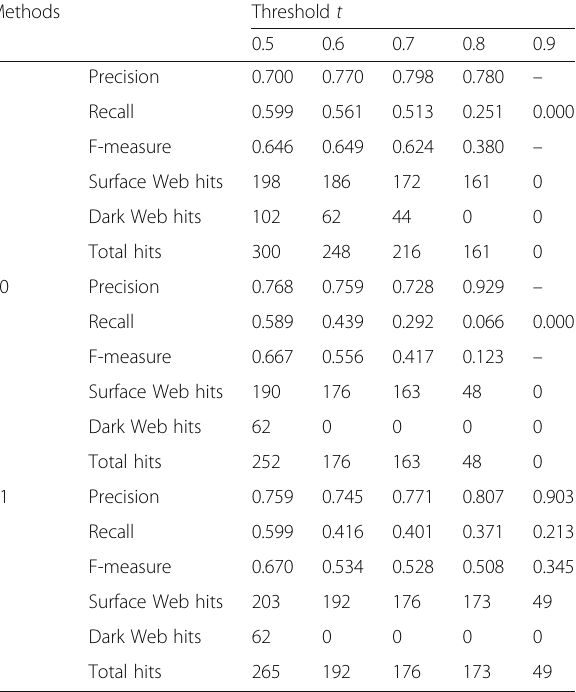
Table 5 Focused crawler effectiveness and efficiency when the third group of hyperlink selection methods are